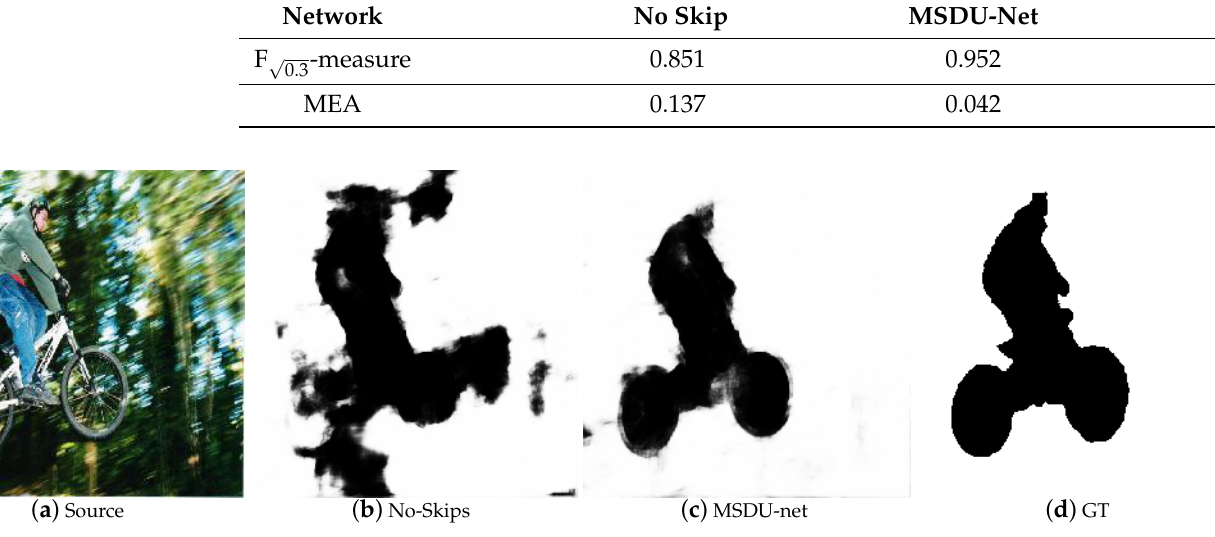
Figure 7. Visual comparison results between MSDU-net and the model without skip